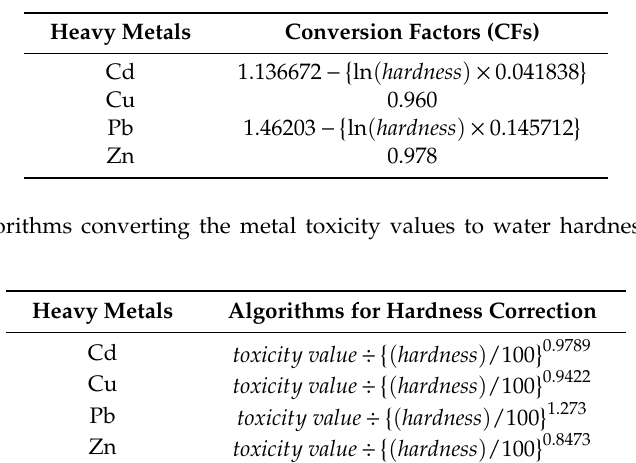
Table 1. Conversion factors (CFs) from dissolved metal to total metal [18].